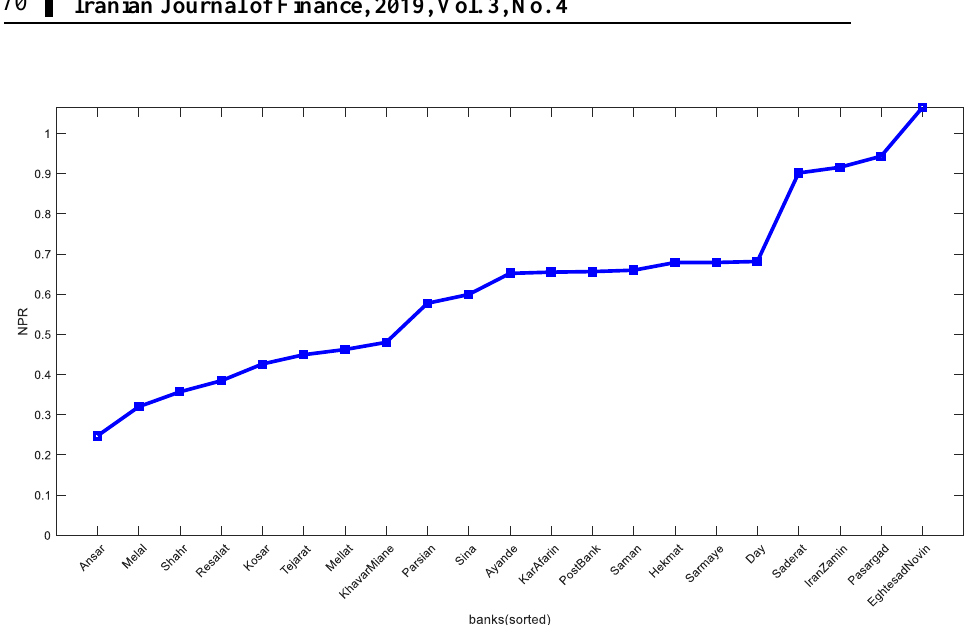
Figure 6. of banks has been shown. It can be seen E. Novin bank has the most NPR and the Ansar bank has the lowest